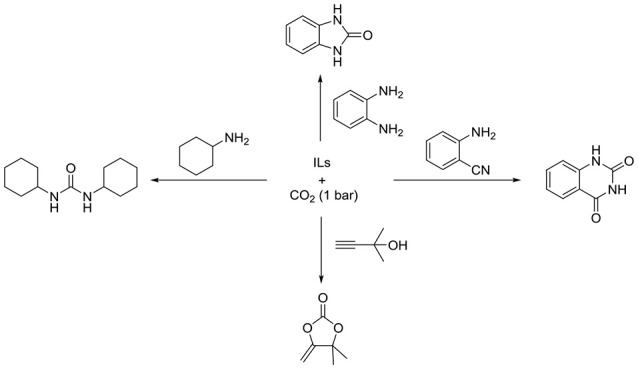
CO2 conversions catalyzed by ILS.